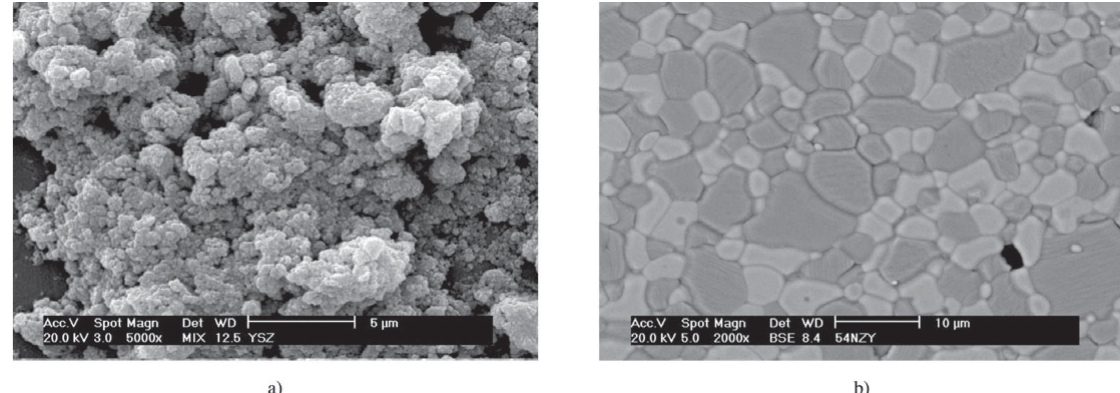
Figure 5 . SEM micrograph of the YSZ-12.5%wt NiO powder (a); the thermally etched YSZ-54wt% NiO ceramic (b).